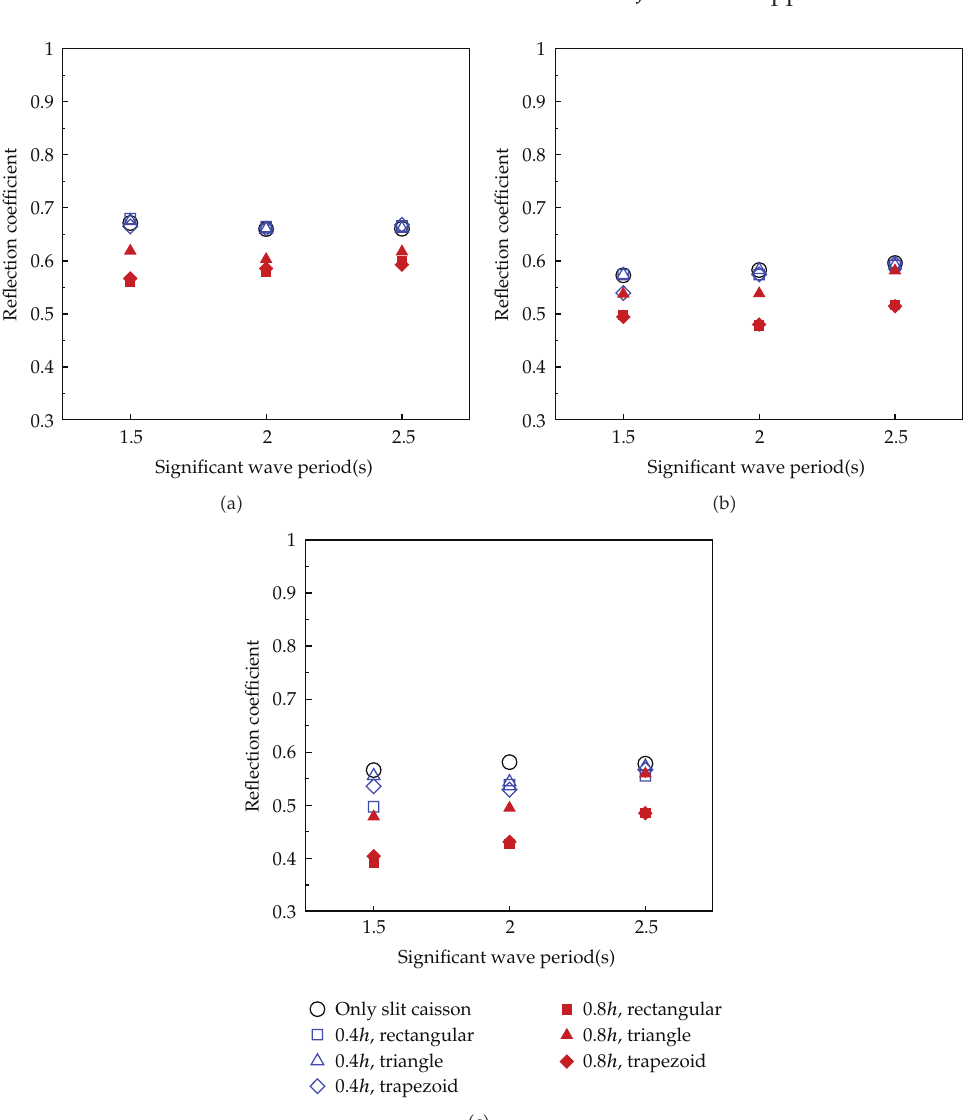
Figure 6: Reflection coe ffi cient for slit caisson with di ff erent significant wave